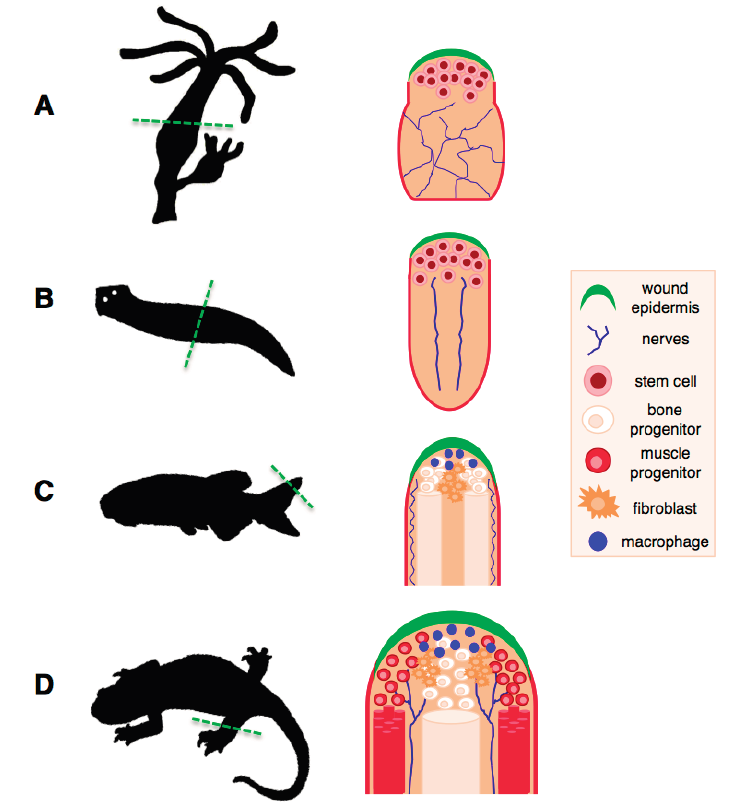
Figure 2. Regeneration of complex structures in classic regeneration models. ( A ) Regeneration of a hydra polyp following amputation across the body stalk. Regeneration takes place through mobilisation and activation of multipotent endodermal and ectodermal stem cell populations; ( B ) Regeneration of a planarian flatworm following bisection. This process takes place through recruitment of pluripotent stem cells, termed “neoblasts”, which are present throughout the animal and carry out tissue maintenance functions. A single clonogenic neoblast is capable of regenerating an entire organism; ( C ) Regeneration of the zebrafish fin. Upon amputation of the fin, differentiated cells at the amputation plane undergo dedifferentiation and proliferate to form a pool of progenitors called a